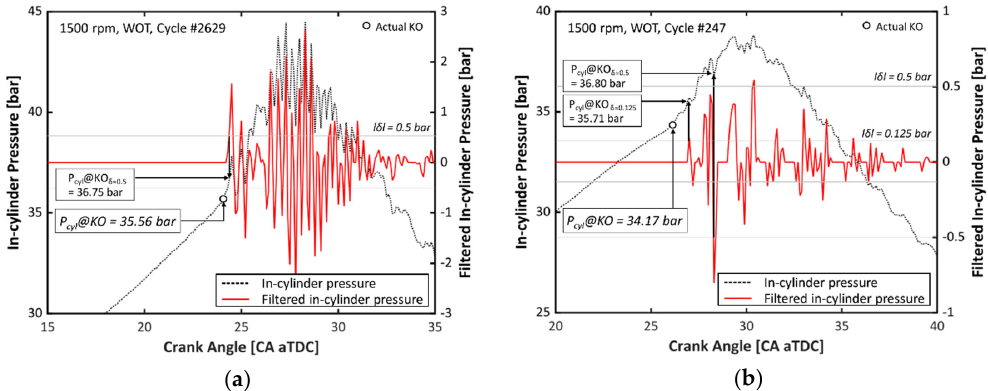
Figure 3. Error in determination of KO by TVE method: ( a ) heavy knock condition; ( b ) weak knock condition. KO: Knock-onset; TVE: Threshold value exceeded.